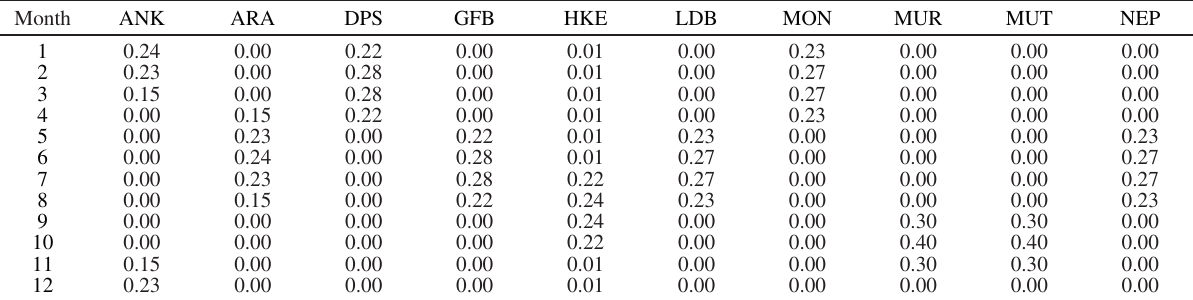
Table 2. – Recruitment timing, by species and month, expressed in percentage. Species codes as in Table 1.